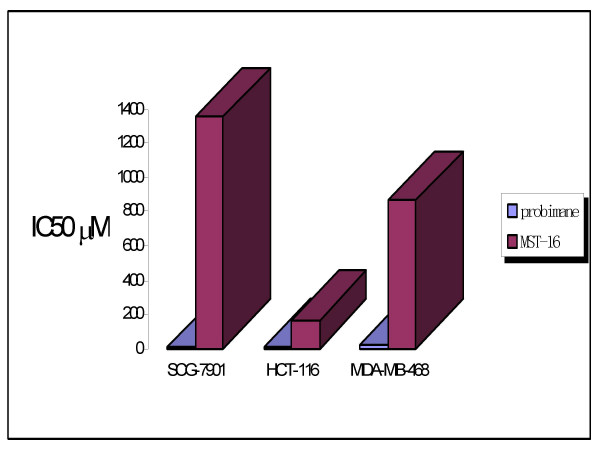
The IC50 of probimane and MST-16 on 3 human tumor cell lines (SCG-7901, HCT-116 and MDA-MB-468) for 48 h exposure. MTT method was used.